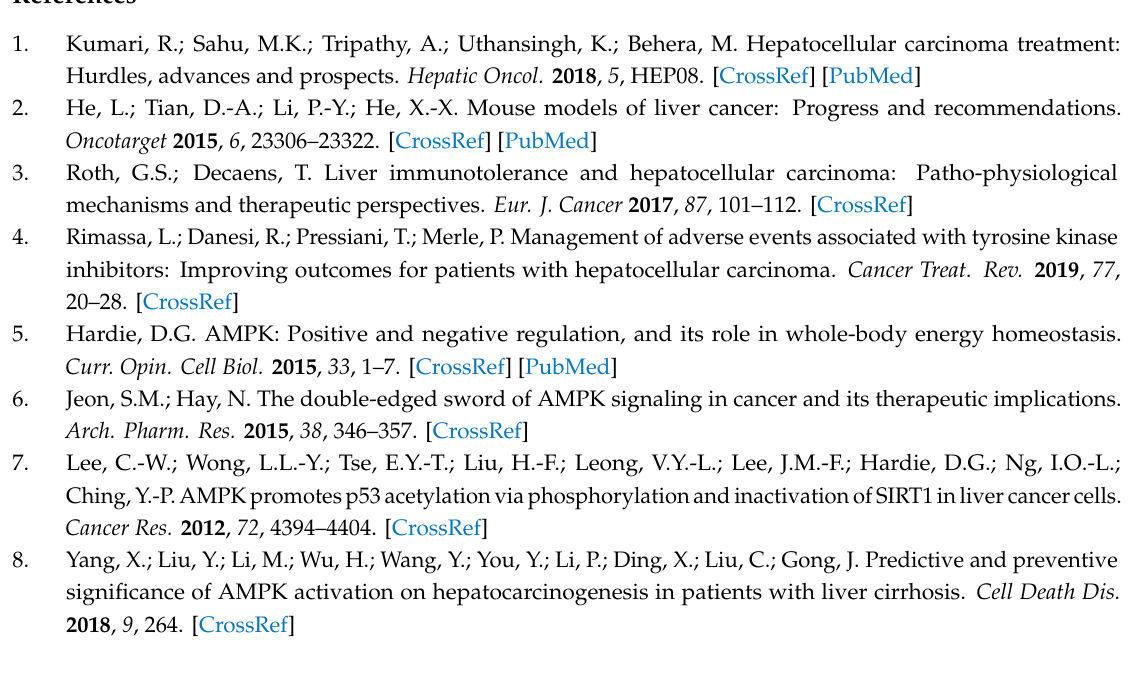
Table S1:Summary of the proteomic results comparing MET versus CTR, METCC versus MET, CTRCC versus CTR; Table S2: Proteins di ff erentially expressed the comparison MET versus CTR; Table S3: Proteins di ff erentially expressed the comparison CTRCC versus CTR; Table S4: Proteins di ff erentially expressed the comparison METCC versus CTR; Figure S1: Hierarchical clustering heatmap from One-way ANOVA analysis of the entire set of metabolites di ff erentially